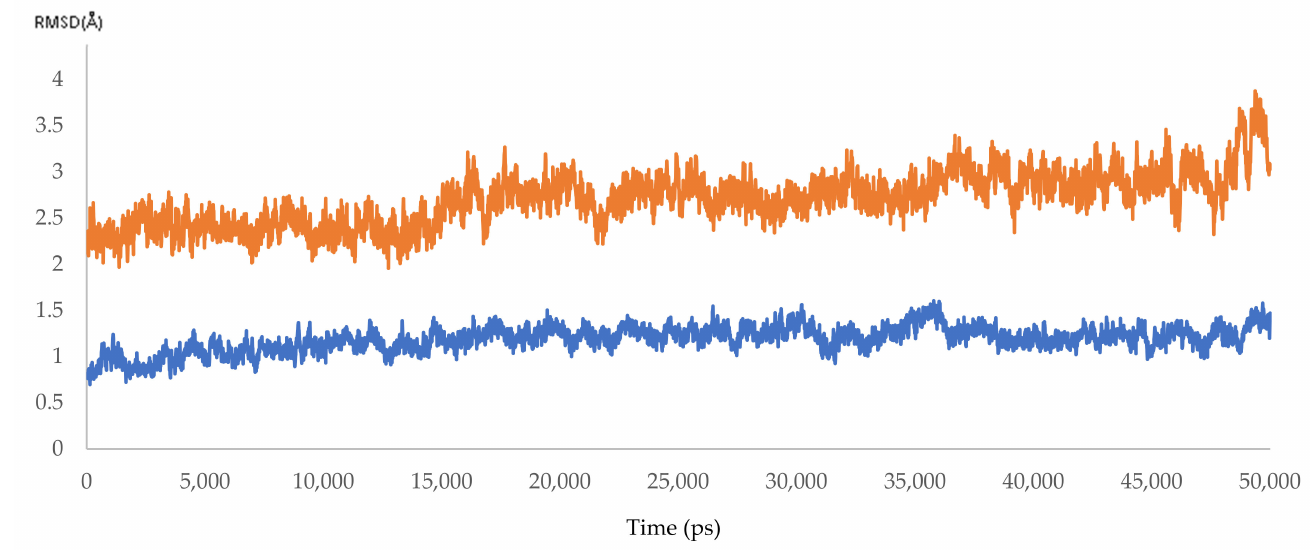
Figure 9. The RMSD of HCV 4a NS5B, comparing the highest resistant and responder samples (3.4 and 1.8 Å).